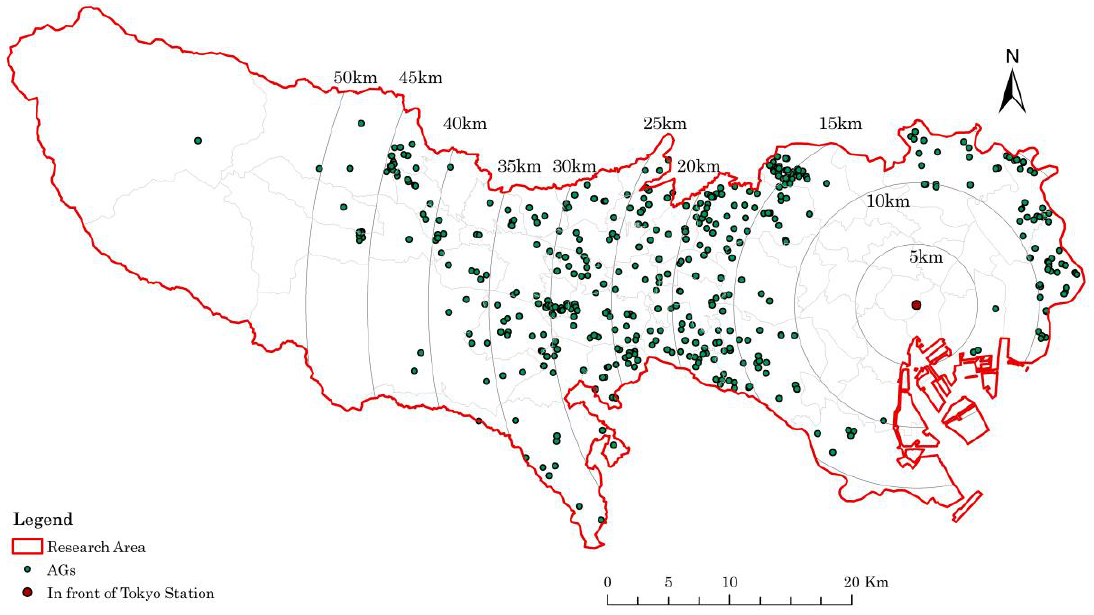
Figure 10. AGs and the multi-distance zones from the center of Tokyo.